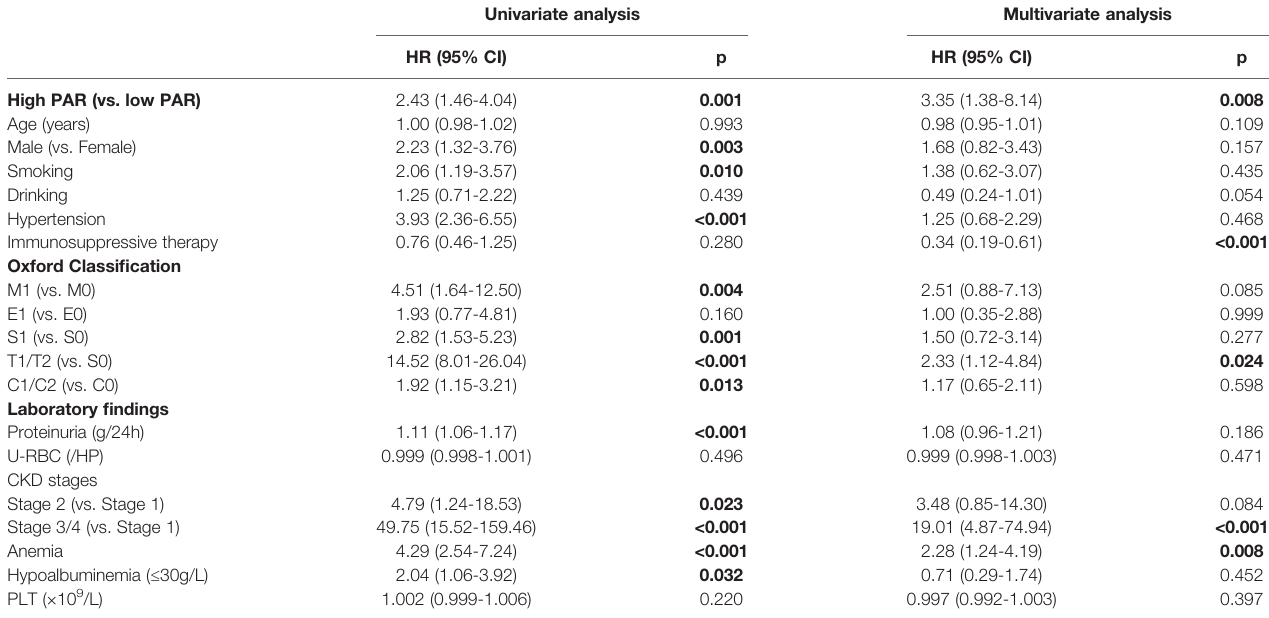
TABLE 1 | Prediction of renal outcomes in the IgAN carried out by Cox-regression analysis adjusted for PAR, clinicopathologic fi ndings and demographic data. Univariate analysis Multivariate